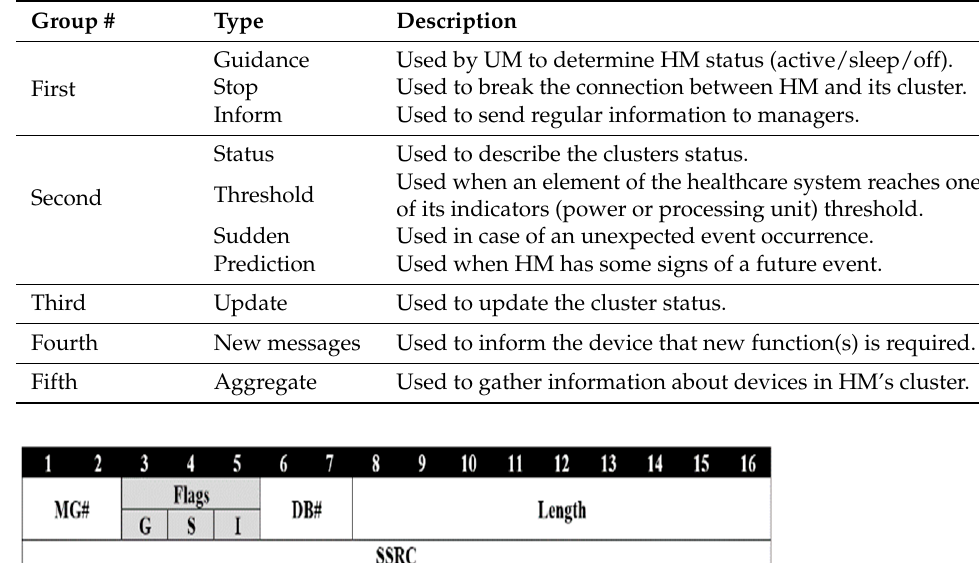
Table 1. Management messages and their summarized functions.